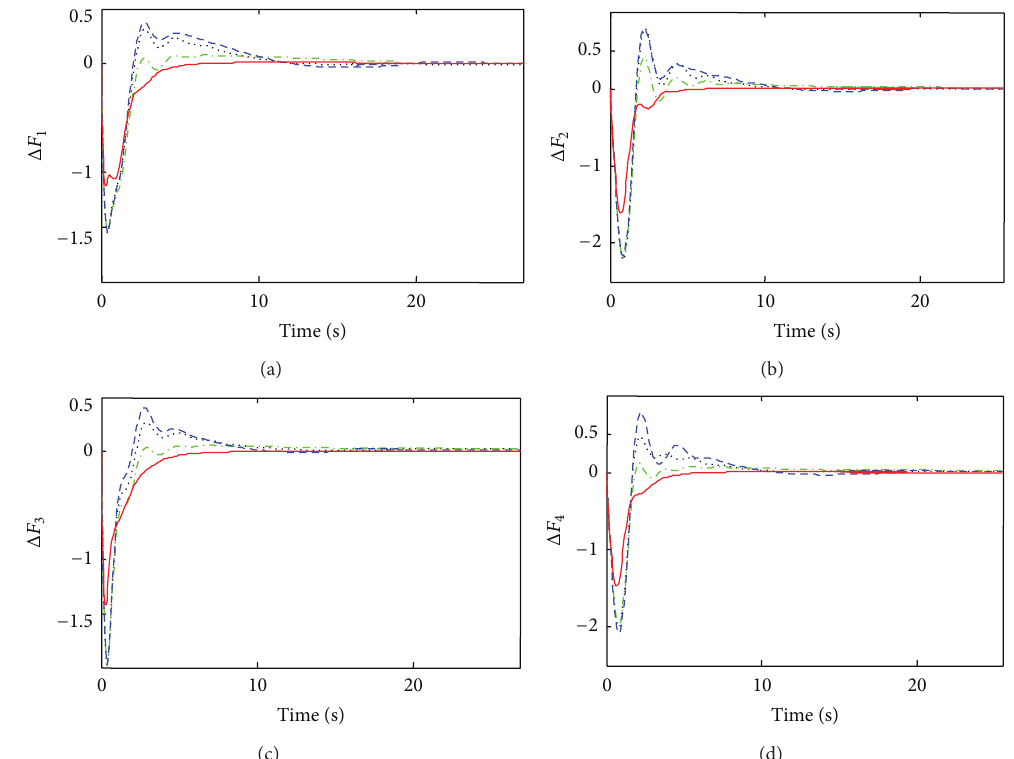
Figure 9: Deviation of frequency; (a) area 1, (b) area 2, (c) area 3, and (d) area 4 for +0% change of parameters; Solid (IABC), Dashed (HPSOCFA), Dashed Dotted (RGA), and Dotted (BGA).